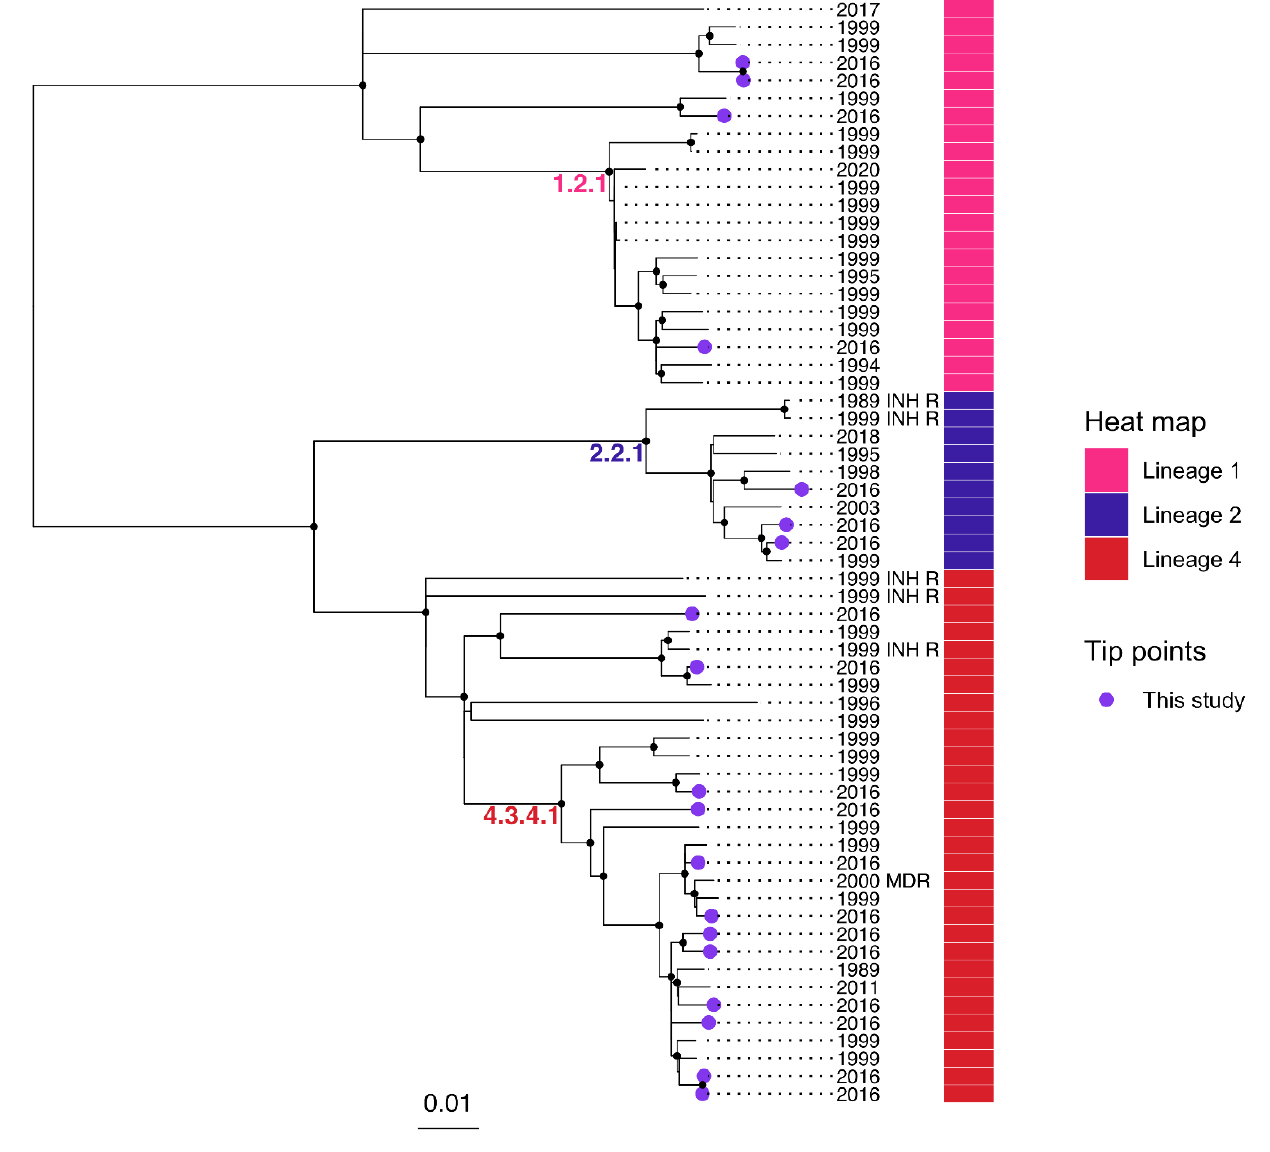
Figure 1. Midpoint-rooted maximum-likelihood phylogenetic tree including 19 study genomes from Timor-Leste, and 43 context genomes from TB cases born in Timor-Leste [14]. A sequence alignment including 8325 SNPs was used to infer the phylogeny. Nodes with approximate likelihood ratio >95 and ultrafast bootstrap >95 are marked with a black circle. Scale bar indicates substitutions/site. MDR, multidrug-resistant; INH R, isoniazid-monoresistant; based on mutations identified by TBProfiler [16].